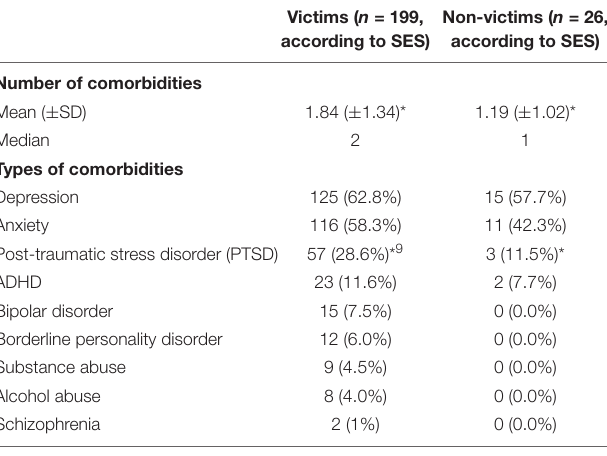
TABLE 7 | Consequences within 6 months of